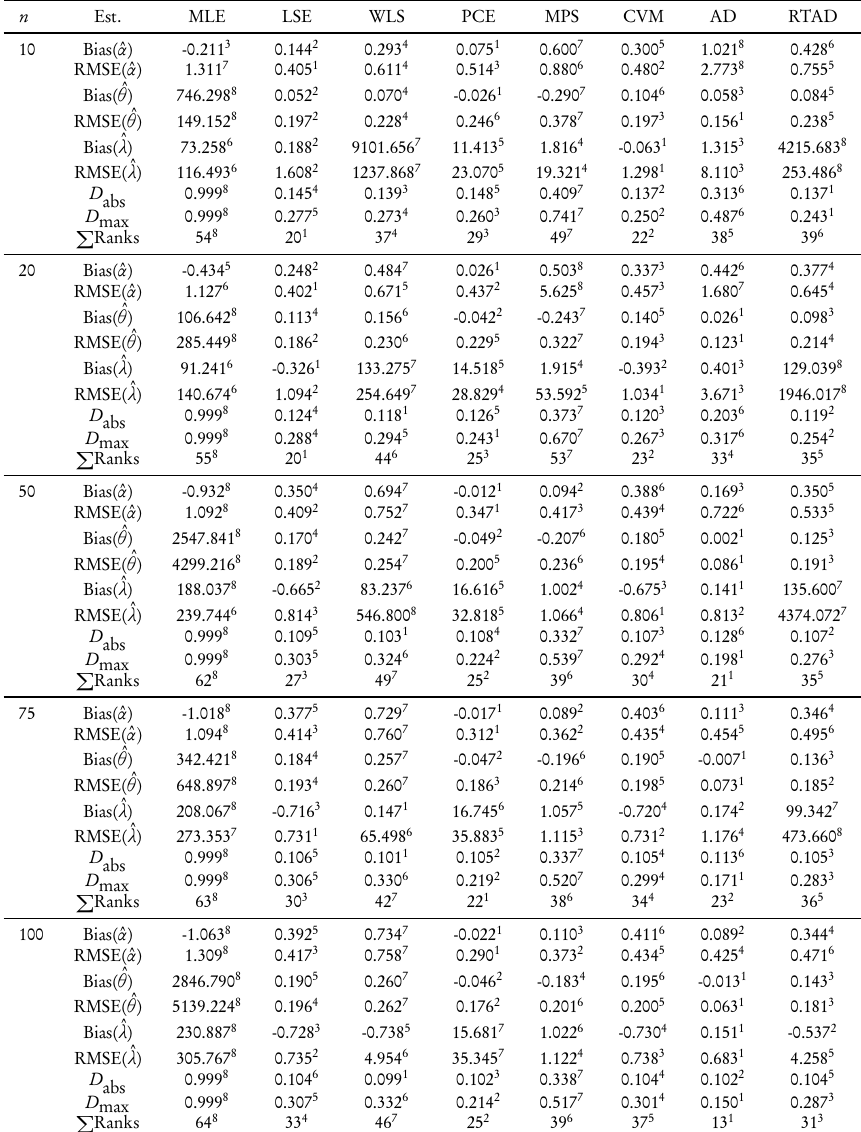
Simulation results for α = 0.7 , θ = 0.9 and λ = 0.3